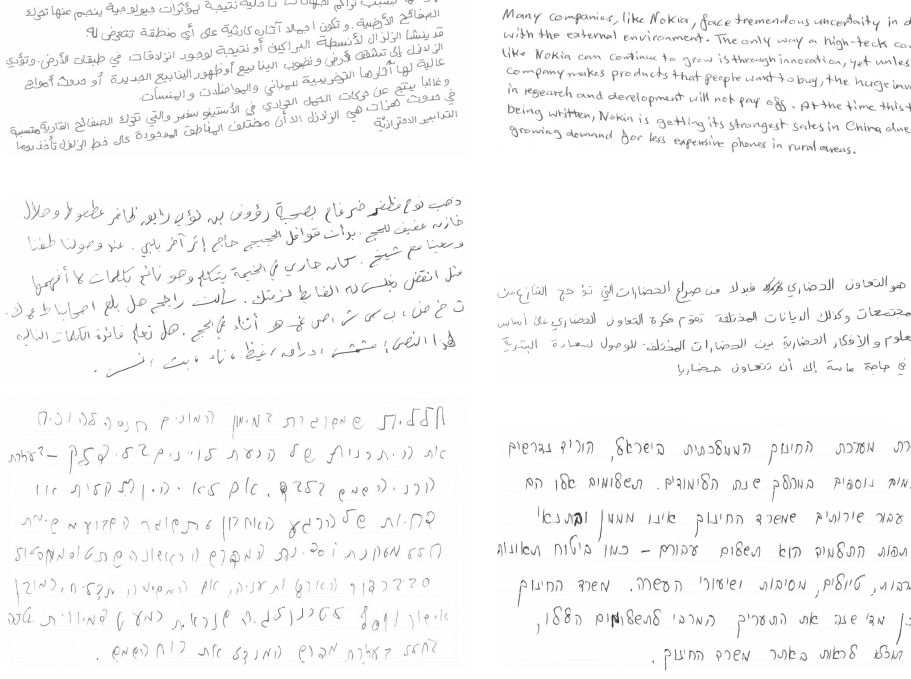
Figure 2. Sample images from the QUWI dataset (top) with Arabic and English handwriting, the KHATT dataset (middle) with Arabic handwriting, and the HHD dataset (bottom) with Hebrew